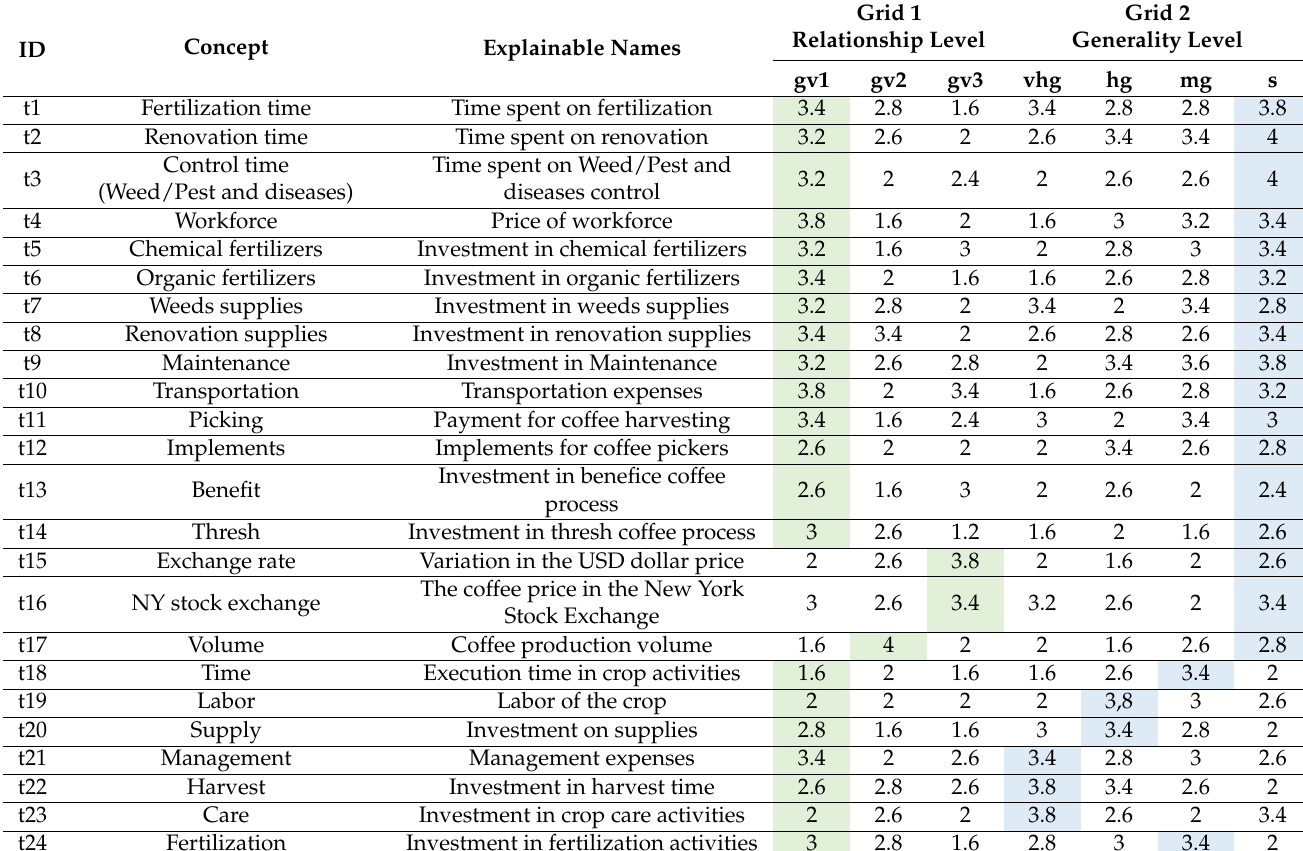
Table 3. HMP-Coffee Summary Grid. Grid 1 analyzes the relationship Level: rows contain the HMP-Coffee brainstorming concepts and columns include the global concepts Production Cost, Market and Production volume. Grid 2 analyzes the generality Level: rows contain the HMP-Coffee brainstorming concepts and columns include generality levels: Very High Generality(vhg), High Generality(hg), Medium Generality (mg) and Specific(s). Cells represent the values assigned by experts to the relationships between columns and rows. Furthermore, the explainable name column contains new names by the 24